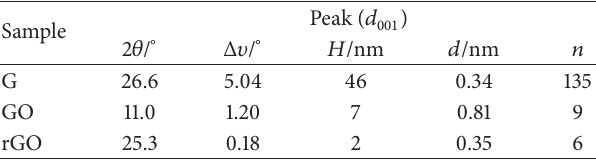
Table 1: Comparison of structural parameters of G, GO, and rGO resulting from the XRD patterns.